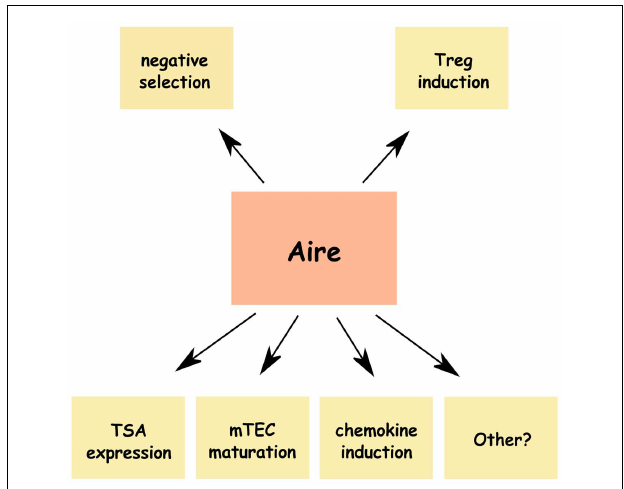
FIGURE 1 |Alternative mechanisms ofAire-induced central tolerance . In addition to the well-described roles in tissue-specific antigen (TSA) expression and induction of negative selection Aire has been shown to affect maturation of medullary thymic epithelial cells (mTECs), expression thymic chemokines, and induction of naturally occurringTregs, which may all contribute to the induction of central tolerance. Other possible mechanisms, such as induction of mTEC apoptosis or disturbances in thymocyte maturation have also been suggested.